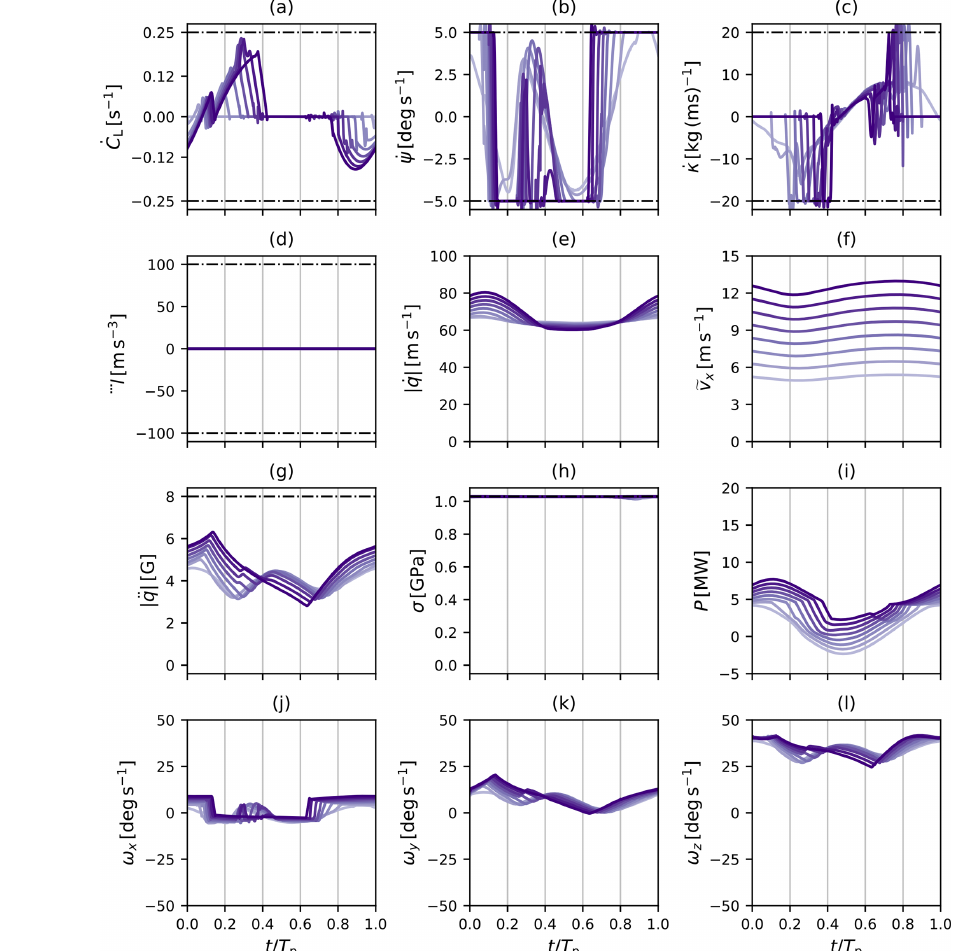
Figure B4. Time series of the controls and additional quantities normalised over one period T p for the large-scale drag-mode AWE system optimised for the wind speed range U D = [ 5 . 0 , 12 . 0 ] . The control variables, i.e. the time derivatives of lift coefficient ˙ C L , roll angle ˙ (cid:57) , and ... l are shown in (a–d) . The magnitude of the flight speed |˙ q | and the streamwise wind speed U x thrust coefficient ˙ κ , and the tether jerk are shown in (e) and (f) . The magnitude of acceleration |¨ q | , the tether stress σ , and the instantaneous power P are shown in (h, i) . The components of the angular velocity ω are shown in (j–l) . The colour scheme is identical to Fig. 3, and the black dashed lines represent the eventual constraints applied to the variables in POCP (Eq.